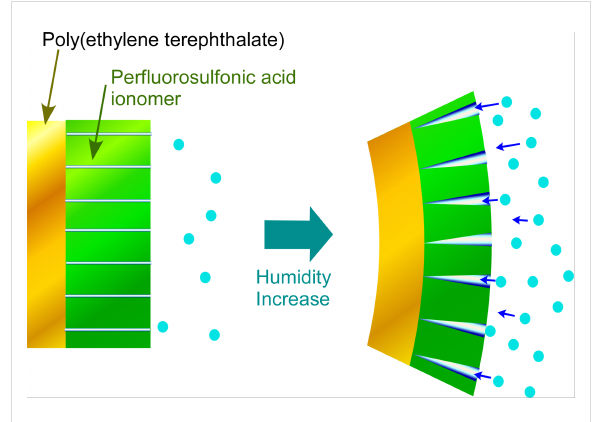
Figure 5: An electrolyte-gated organic field-effect transistor with anti- bisphenol A antibody. The addition of bisphenol A induces the removal of the antibody from the sensor surface, resulting in an increase in the drain current.